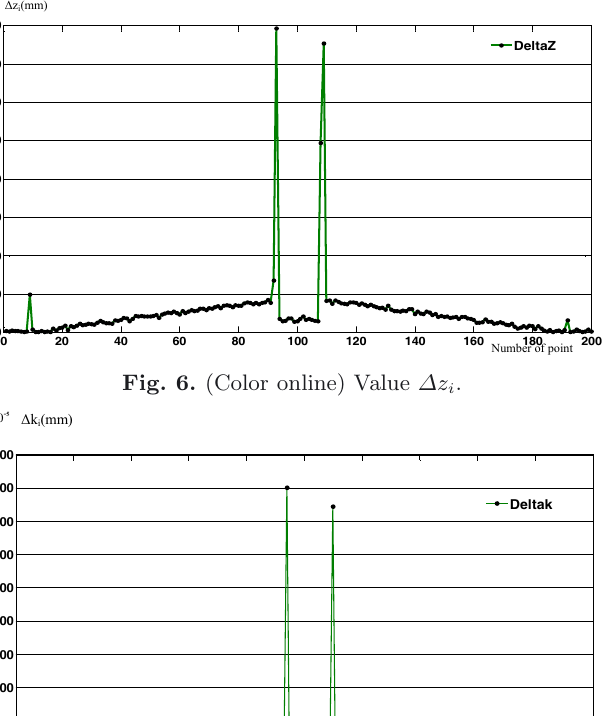
Fig. 7. (Color online) Value Δk i .